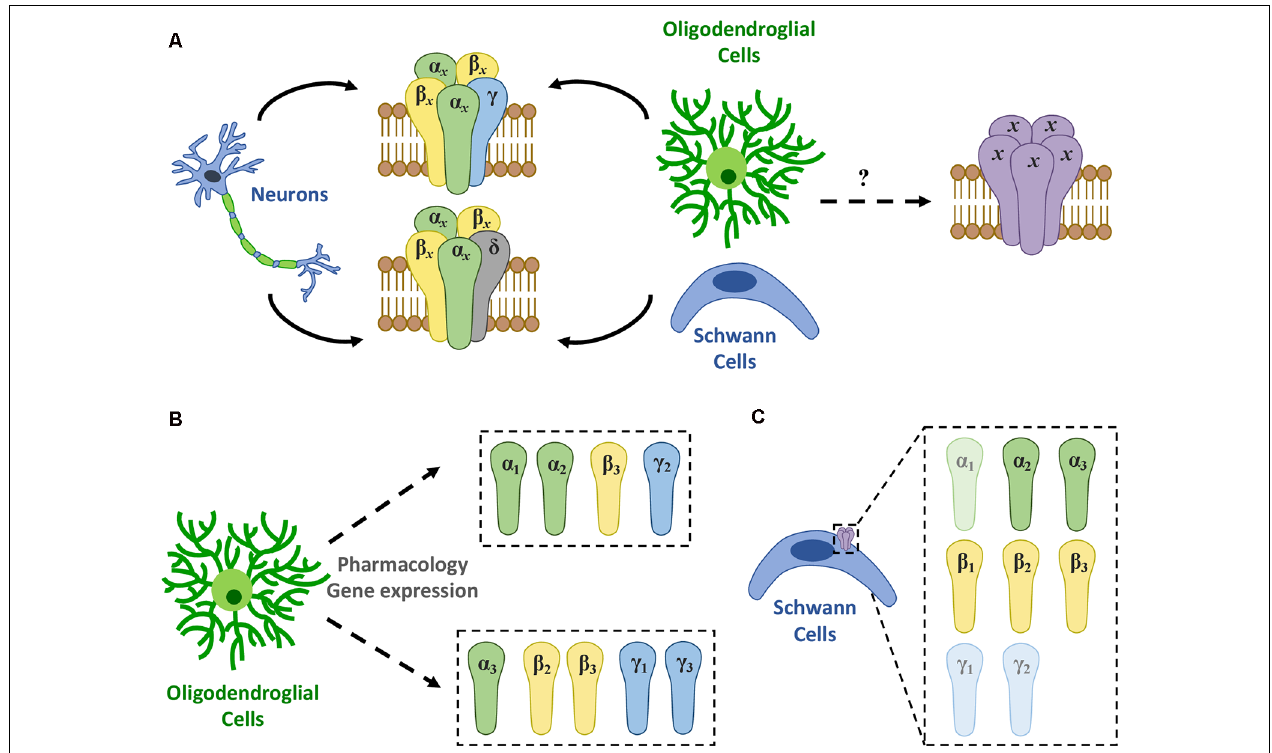
FIGURE 1 | GABA A R expression in myelinating cells. (A) There are 11 different GABA A R subtypes described, mainly heteromeric receptors with α x β x γ x or α x β x δ (where x represents any subtype of a given subunit) stoichiometry (Olsen and Sieghart, 2008). Among them, a single type of GABA A R appears to be present in oligodendrocytes though its molecular nature remains elusive. (B) Recent evidence using gene expression and pharmacology shows that GABA A Rs in oligodendroglia are heterogeneous and may change in subunit composition during differentiation. Thus, at least two novel subtypes were identified: one formed by a combination of α 1 or α 2, β 3, and γ 2 subunits (Passlick et al., 2013) and another made up by α 3, β 2 or β 3, and γ 1 or γ 3 subunits (Arellano et al., 2016). (C) In turn, studies using RT-PCR and/or immunohistochemistry conclude that SCs express high levels of α 2, α 3, β 1, β 2, and β 3, while α 1, γ 1, and γ 2 levels are relatively low in these cells (Magnaghi et al.,